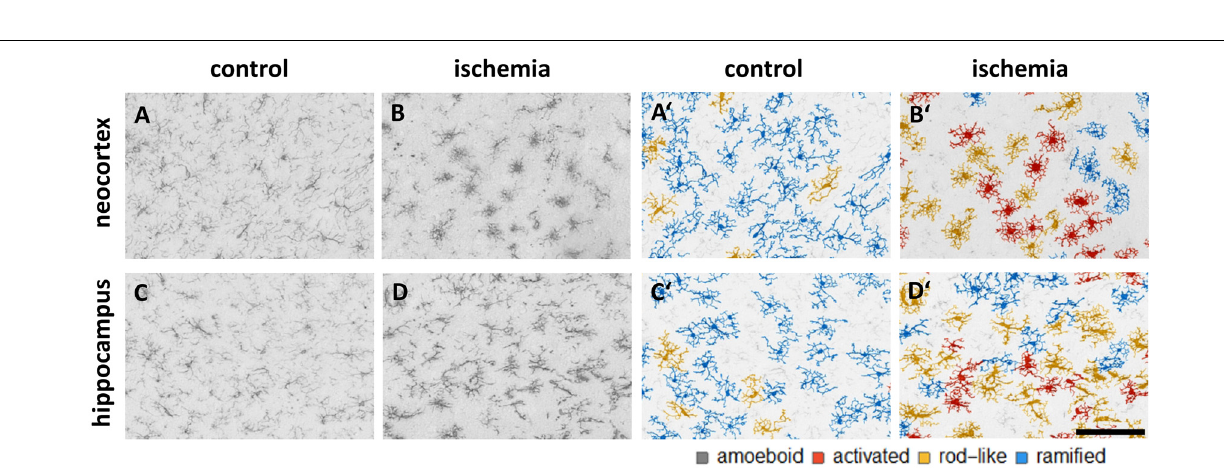
cell circularity, soma area, soma perimeter, soma circularity, skeleton length, skeleton branch poin ts and endpoints, cell processes, branching index, critical radius, dendritic maximum, SRI ) were measured for each detected Iba1-positive cell ( n =